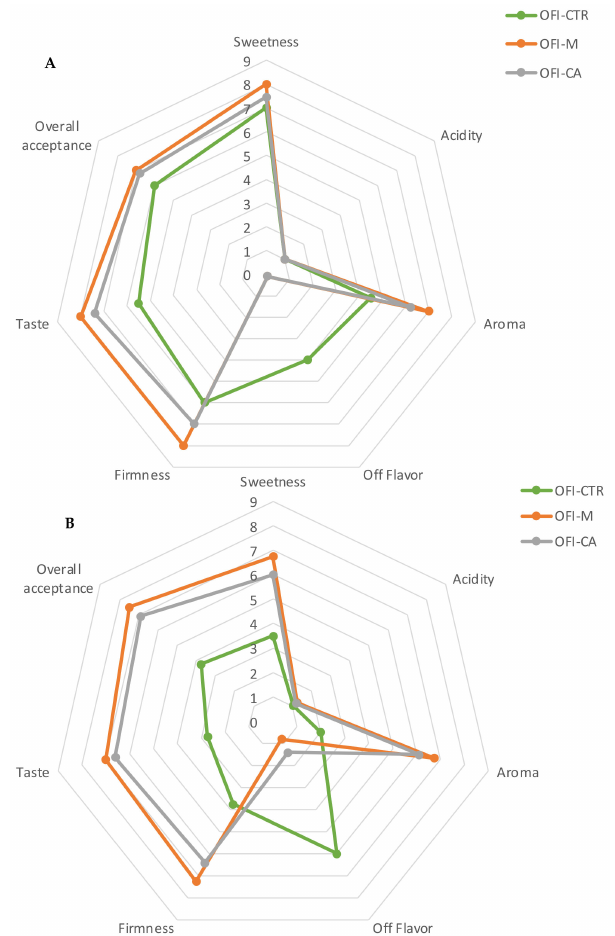
Figure 4. Sensorial analysis of minimally processed O. ficus-indica fruits non-treated (OFI-CTR) and treated with mucilage (OFI-M) and calcium ascorbate coating (OFI-CA) after 3 days ( A ), and 9 days ( B ) of cold storage at 5 ◦ C. Data are the mean ± SE ( n =